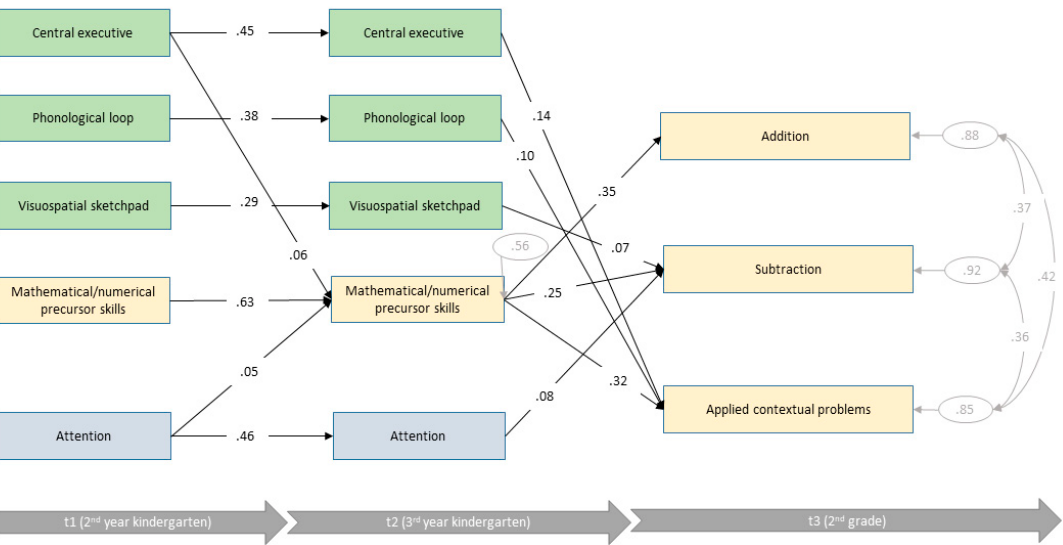
Figure 4. Final path model of average intellectual ability group with standardized path coefficients ( n = 908).